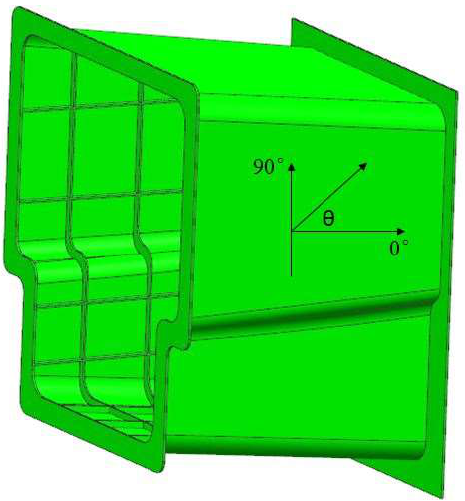
Figure 7. Definition of ply angle in the load-bearing cylinder.